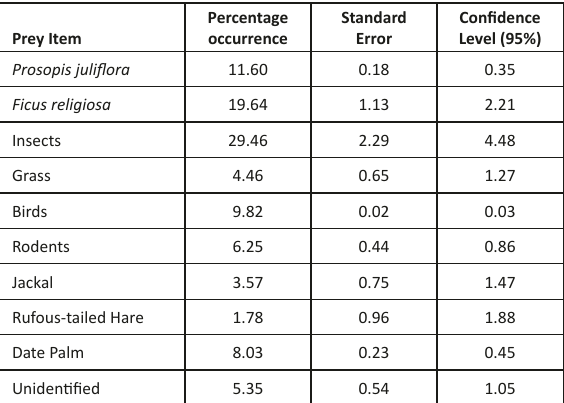
Table 2. Percent frequency of occurrence with standard error and confidence level.